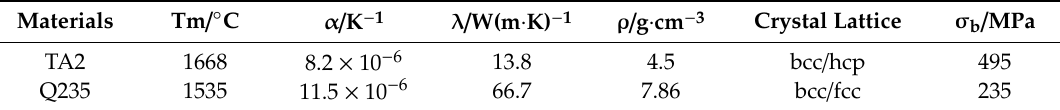
Table 1. Physical properties and tensile strength of Titanium and steel